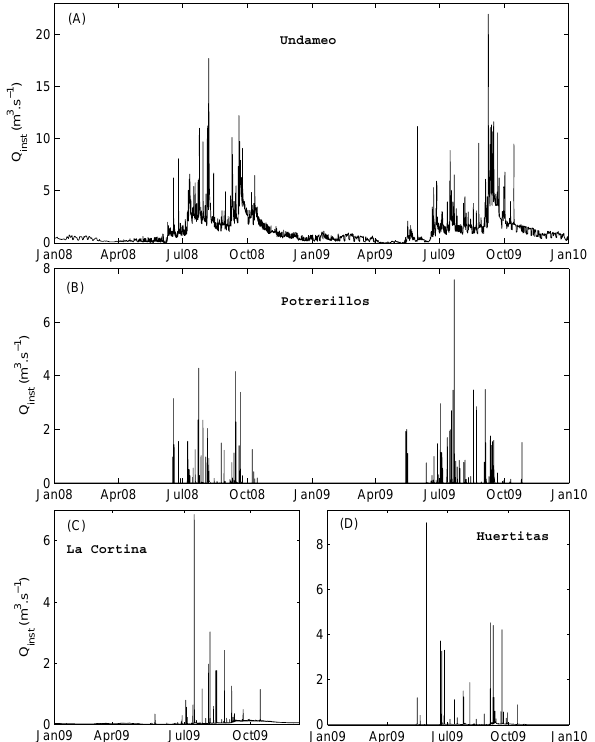
Fig. 2. Discharge records at the four sites. (a and b) correspond to data collected from January 2008 to December 2009 in Undameo and Potrerillos, respectively. (c and d) correspond to data collected from January 2009 to December 2009 in La Cortina and Huertitas, respectively.